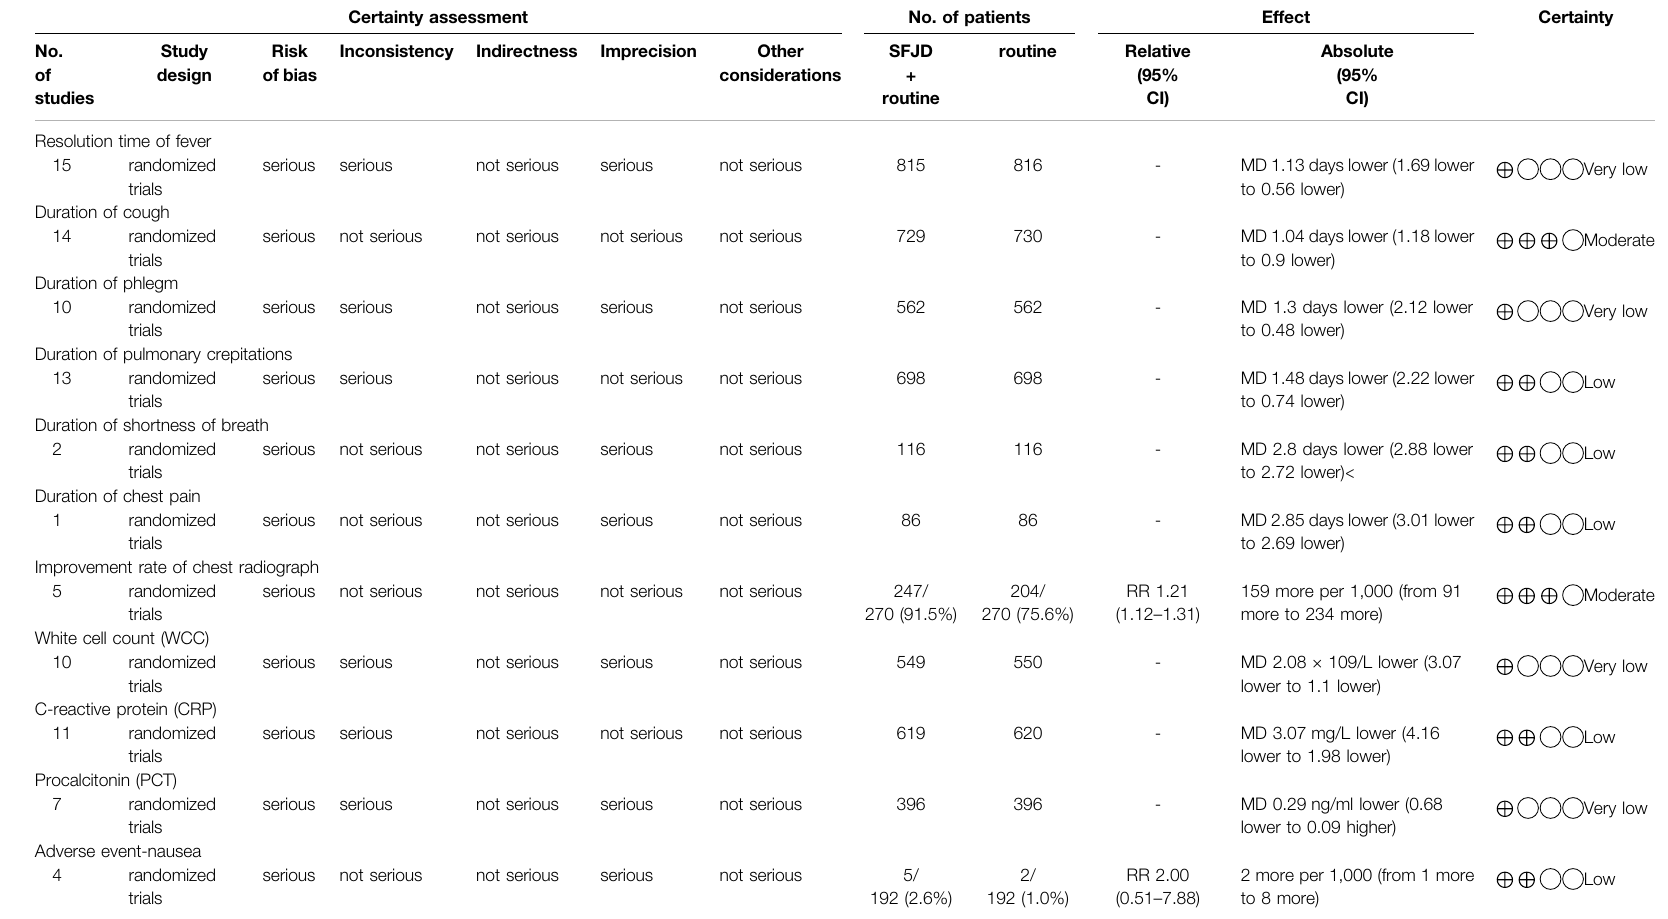
TABLE 3 | Certainty of the evidence according to GRADE, question: Shufeng Jiedu capsules plus routine treatment compared to routine treatment for patients with community-acquired